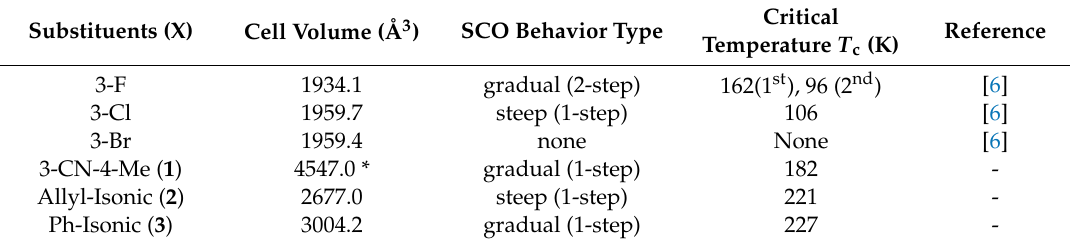
Table 3. Cell volumes, SCO behavior, and critical temperature ( T c ) of the bilayer series for {Fe II (X-py) 2 [Ag I (CN) 2 ] 2 } in HS state.